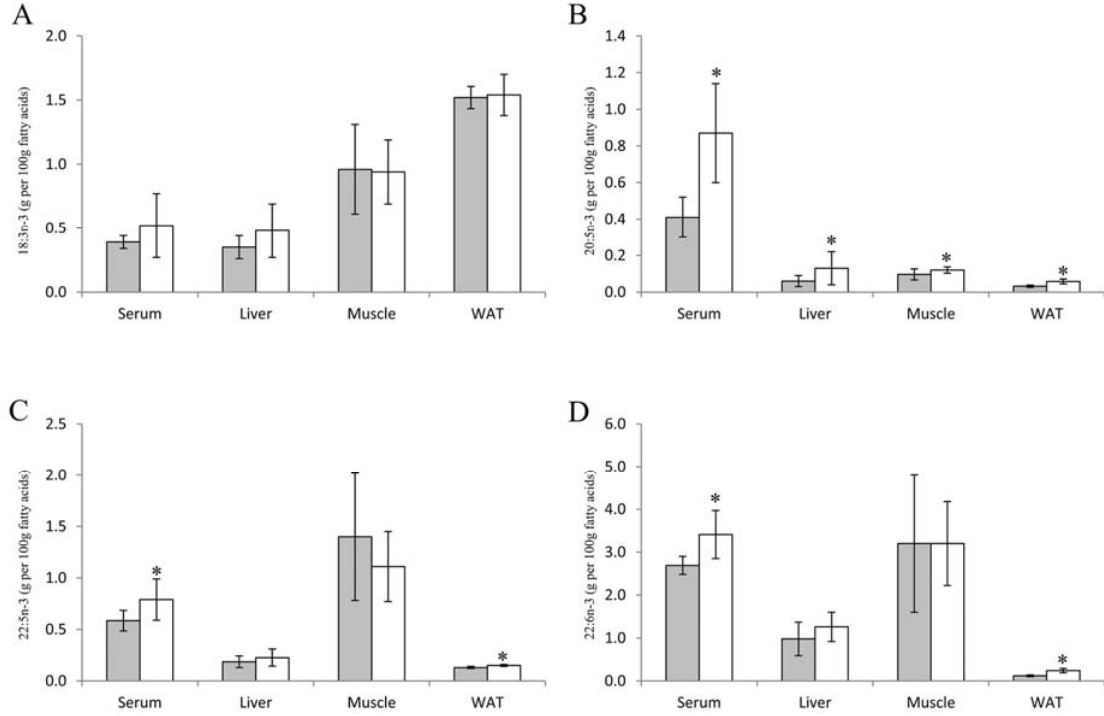
Figure 2. Long chain n ‐ 3 PUFAs in serum, liver, thigh muscle and epididymal white adipose tissue (WAT) in obese Zucker fa/fa rats fed Control Diet (grey bars) or Baked Cod Diet (white bars). Values are mean and standard deviations, n = 9 in Zucker fa/fa Control Group, and n = 10 in Baked Cod Group. Figure shows contents of 18:3n ‐ 3 ( A ), 20:5n ‐ 3 ( B ), 22:5n ‐ 3 ( C ) and 22:6n ‐ 3 ( D ). * Significantly different from rats fed Control Diet. p < 0.05 were considered statistically significant. Groups are compared using Independent Samples t ‐ test assuming equal variances.